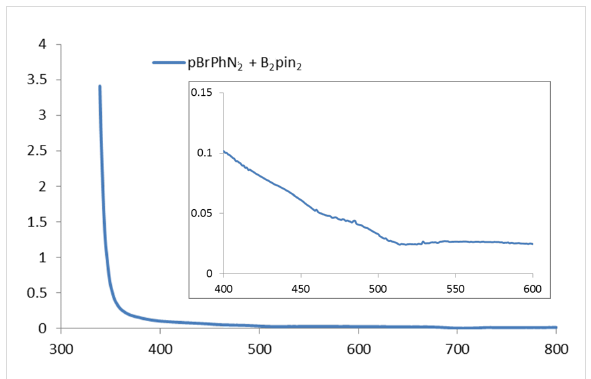
Figure 3: UV–vis spectrum of p -bromobenzenediazonium tetrafluoro- borate (pBrPhN 2 ) and bispinacolato diboron (B 2 pin 2 ) in